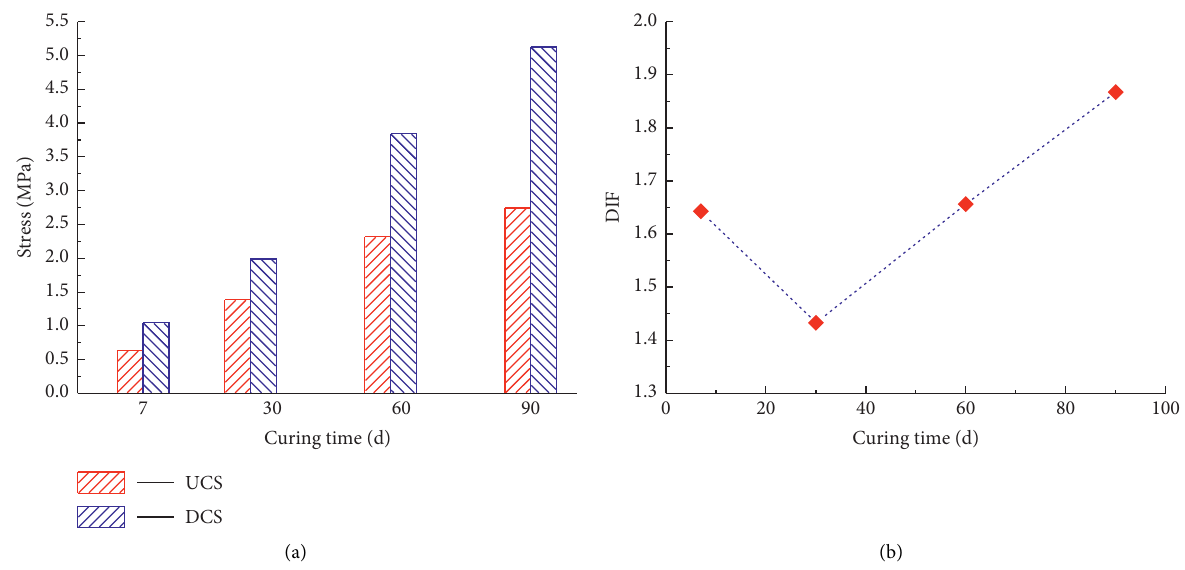
Figure 10: Relationship of strength between static and impact load test. (a) The relationship of DCS and UCS. (b) The curve of DIF with different curing times.